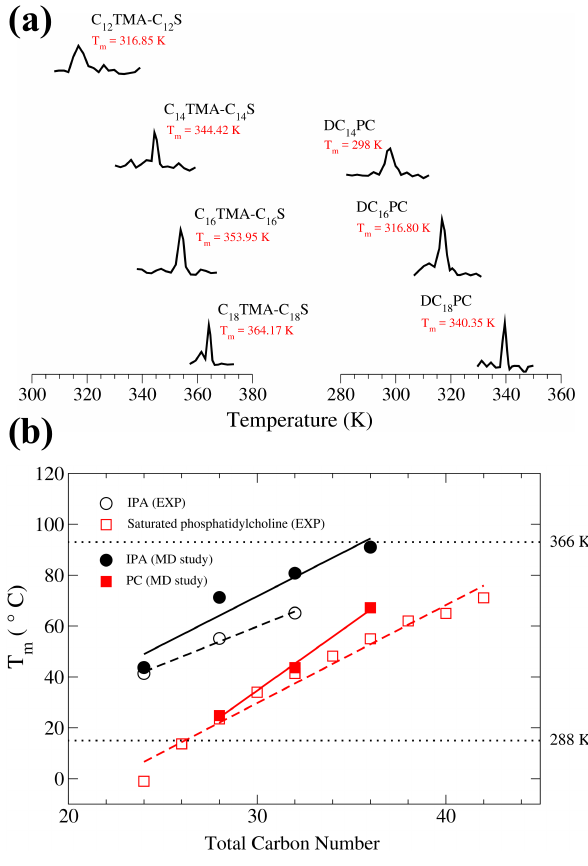
Figure 2. ( a ) Heat capacity profiles for DC n PC and C n TMA-C n S IPA bilayers with various alkyl chain length. T m values denote the maximum peak positions; ( b ) T m versus alkyl chain length plots for DC n PC and C n TMA-C n S IPA bilayers from MD (molecular dynamics) simulations (solid points) compared with experimental data (hollow points)